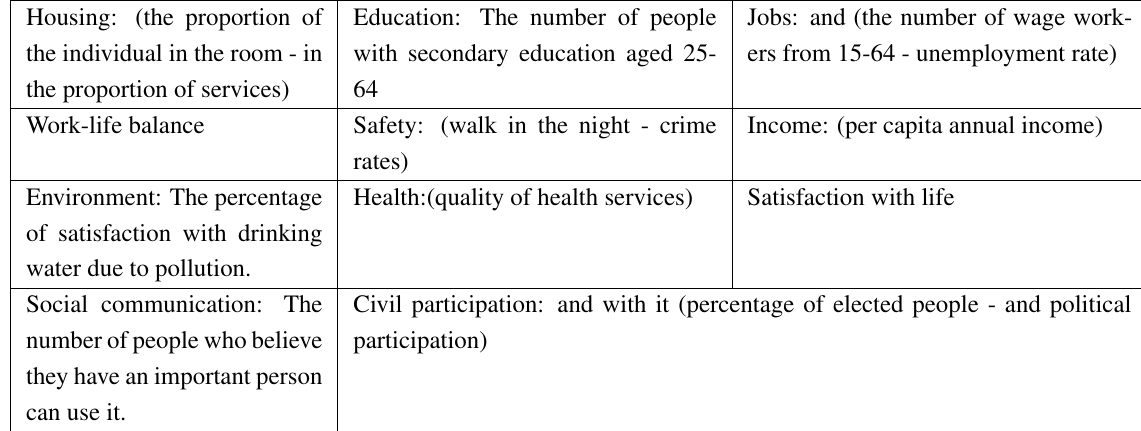
Table 1. MeasuringQuality of Life through the OECD